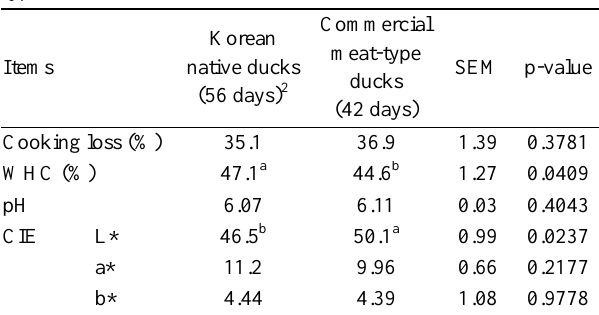
Table 4. Cooking loss, water holding capacity, pH and color of breast meat from the Korean native ducks and commercial